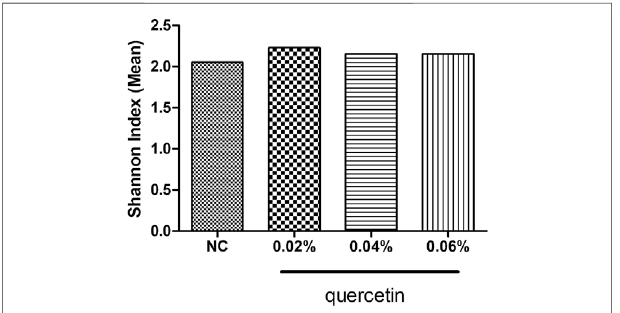
FIGURE 1 | Effect of quercetin on microbial diversity in the ileum of AA broilers, NC (normal control broilers) and quercetin (0.02%, 0.04, and 0.06%) groups.Datawerestatisticallyanalyzedusingone-wayANOVAwithDuncan ’ s test. Values are expressed as means ± S.D., and n = 1 for all groups. Values not marked mean no signi fi cant difference was seen ( p >